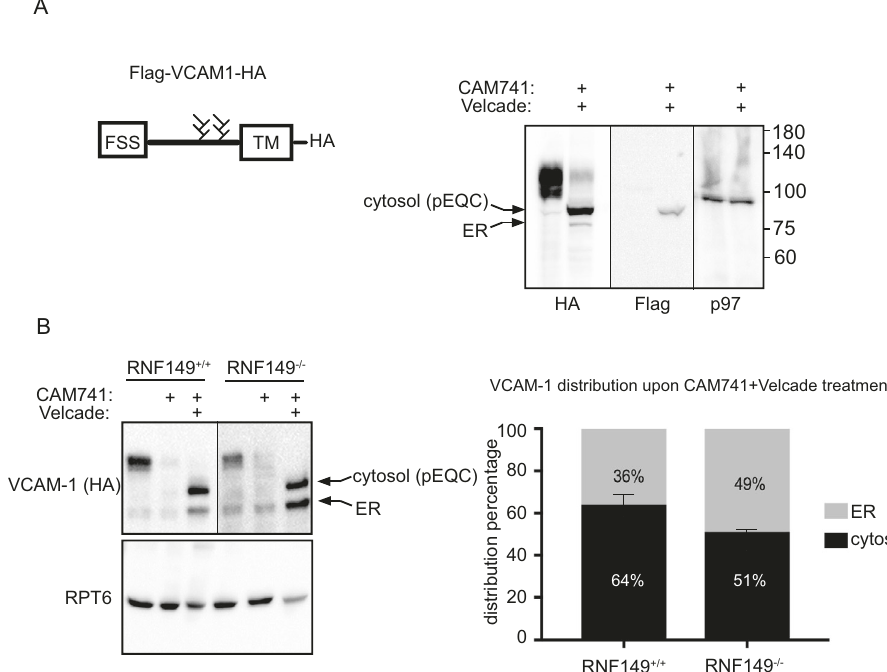
Fig. 4 RNF149 knockout impact on translocation. A Left- Illustration of VCAM-1 containing the Flag signal sequence (FSS), the glycosylation sites, transmembrane domain (TM), and C-terminus HA tag. Right-Cells expressing Flag-VCAM1-HA were untreated or subjected to velcade and CAM741 treatment. The HA immunoblot reveals both ER and cytosol species of VCAM1 whereas the Flag immunoblot reveals only the pEQC non-translocated species that harbors the signal sequence. The lower band that is not recognized by the Flag immunoblot is an ER translocated species whose signal sequence has been cleaved. Proteasomal stabilization of this species (also seen in Fig. 1C with only velcade) indicates that a small percentage of VCAM1 is also subjected to ERAD. B RNF149 wildtype and knockout MEF cells stably expressing VCAM1 were treated with CAM741 and velcade as indicated. Steady state levels of VCAM1 were revealed by a HA immunoblot and ratios of pEQC or ERAD were quanti fi ed and standard deviations from three repetitions are